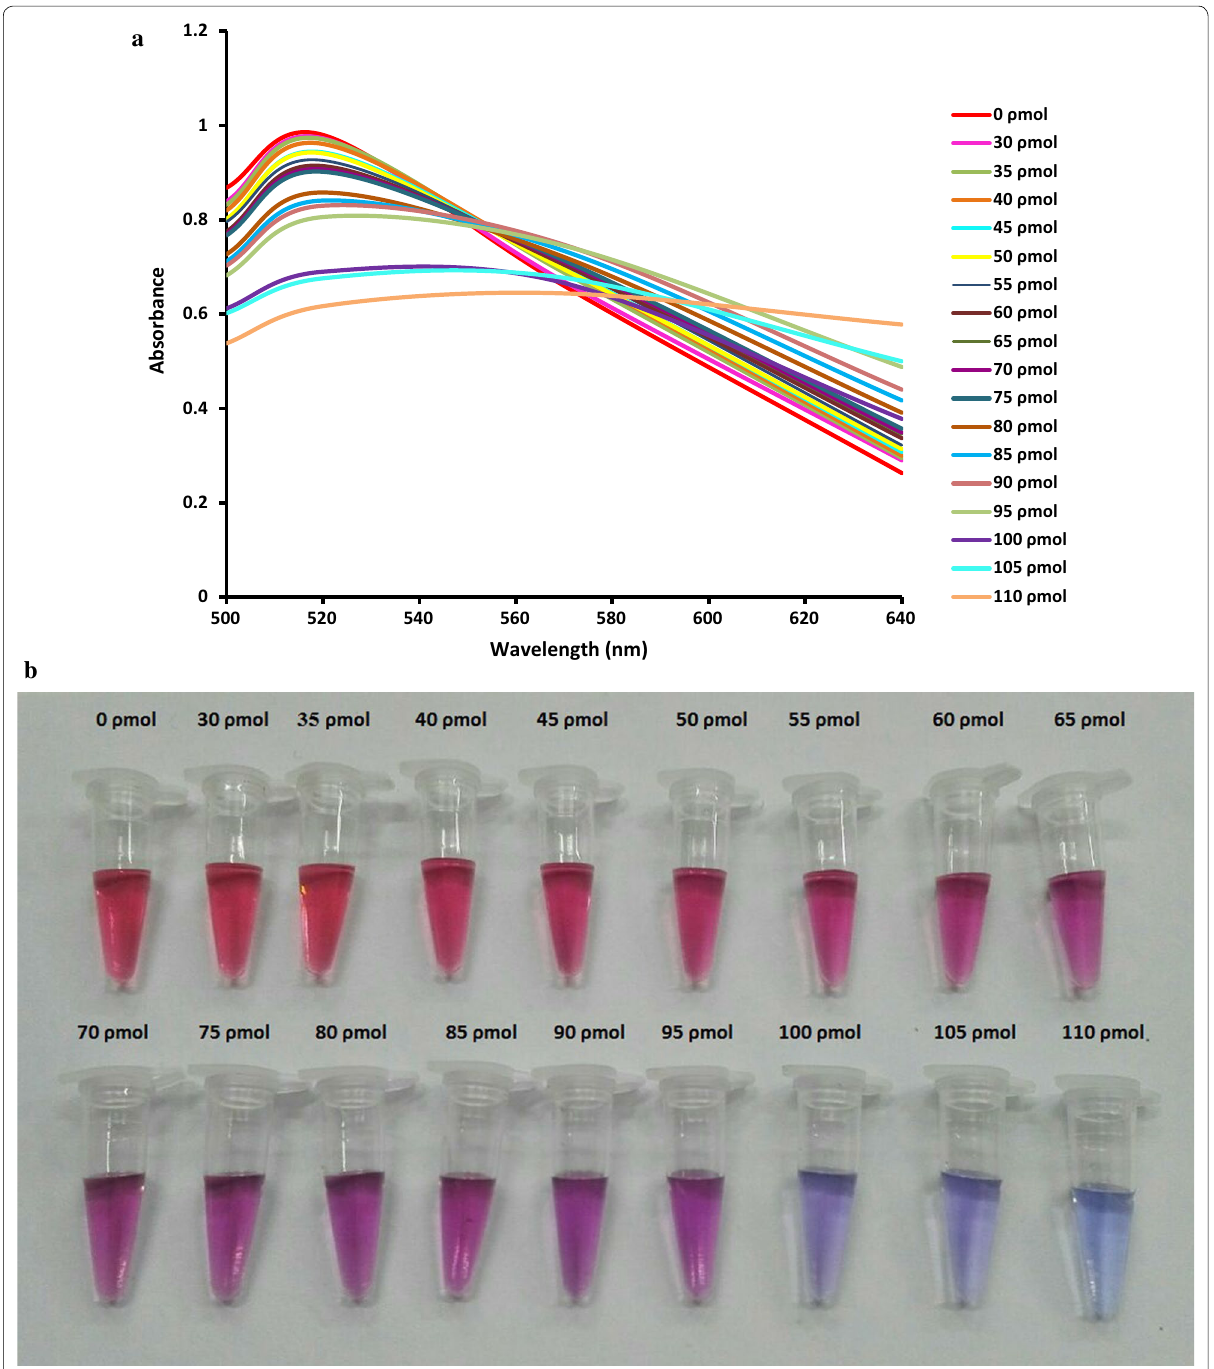
Fig. 1 Optimization of PNA concentration required to aggregation of AuNP. a Absorption spectra of AuNP solutions containing different concentra- tions of PNA. b Visual colors of corresponding